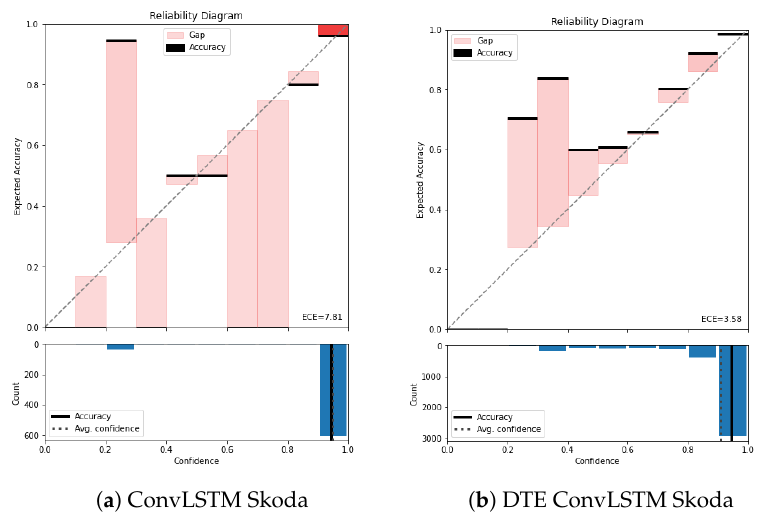
Figure A3. Reliability diagram of Skoda for ( a ) ConvLSTM and ( b ) DTE